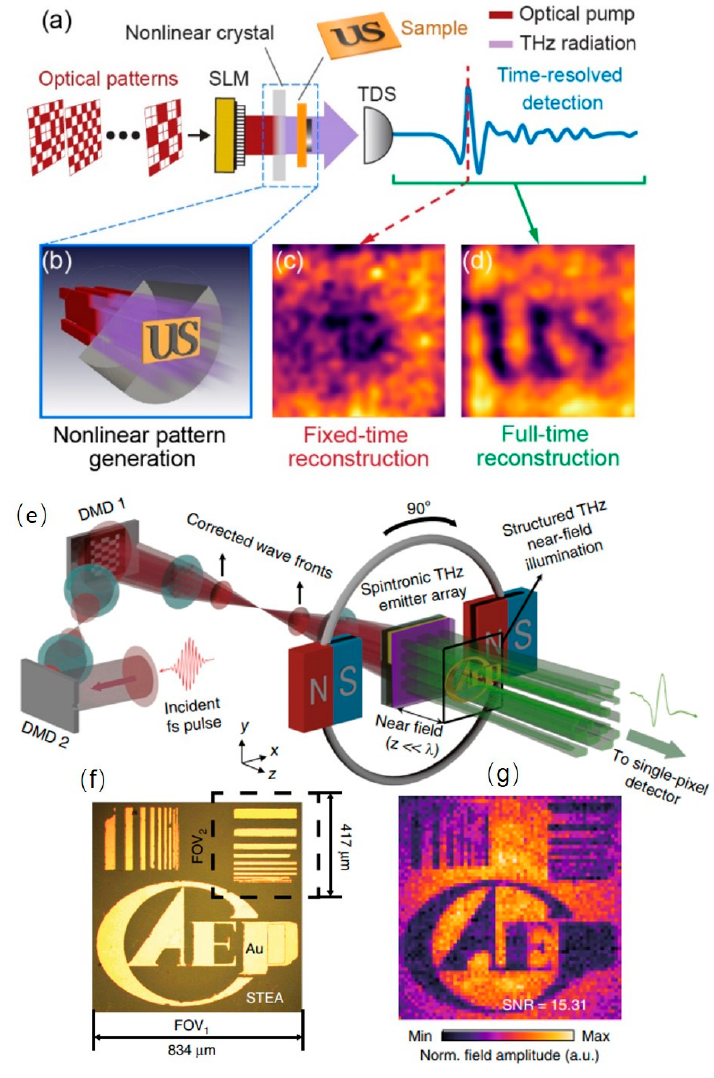
Figure 8. THz spatial modulation during generation. ( a – d ) Single-pixel imaging enabled by spatially modulating the pump laser shined onto the nonlinear crystal, which generates THz patterns for image reconstruction. Reproduced with permission from [92]. Copyright 2018 American Chemical Society. ( e – g ) The spintronic THz emitter array excited by DMD-encoded fs laser radiates structured THz beam for near field ghost imaging. Reproduced with permission from [94]. Copyright of 2020 Springer Nature.